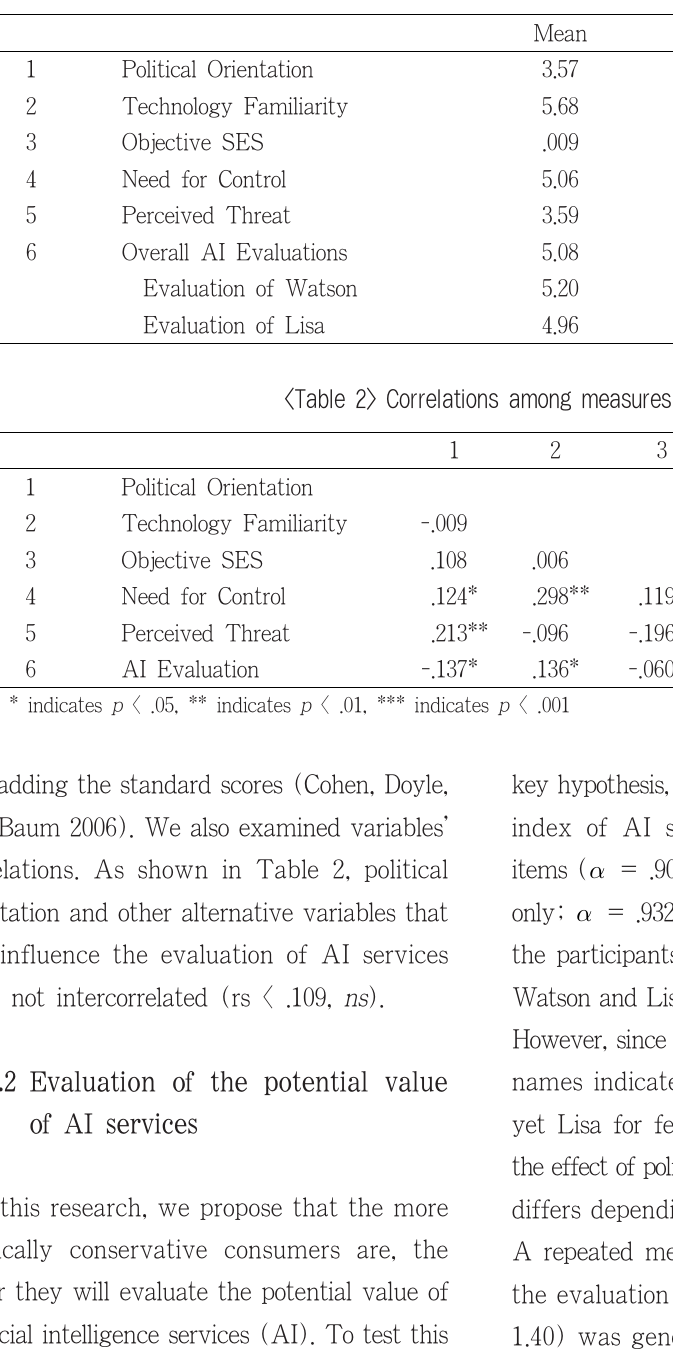
<Table 1> Means and standard deviations of focal and control